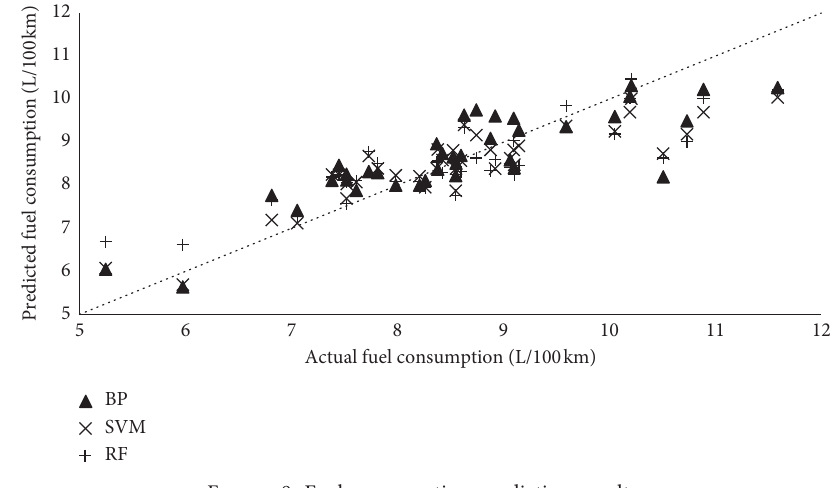
Figure 8: Fuel consumption prediction results. Table 5: Model evaluation